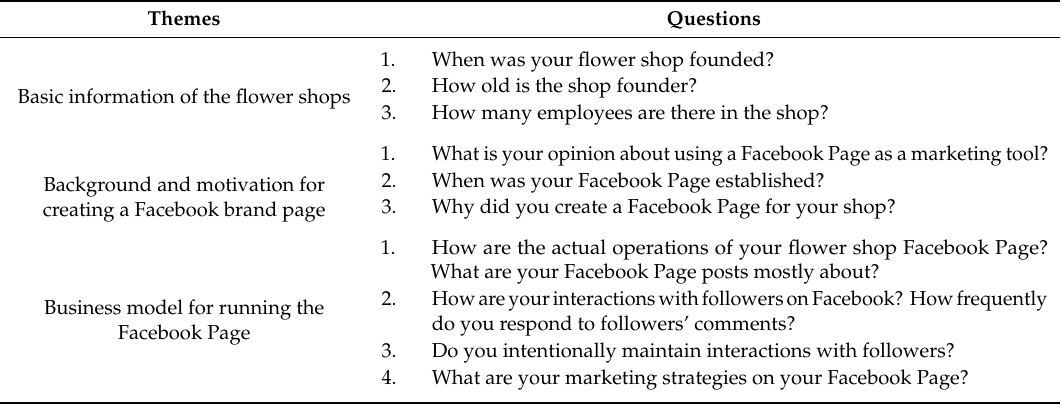
Table 1. Questions used in the interviews conducted with the flower shop owners who were located in Taiwan and hosting a Facebook brand page for achieving the research purpose of exploring the florists’ motivation, management strategy, barriers, and perceived benefits for adoption social media marketing in flower retailing